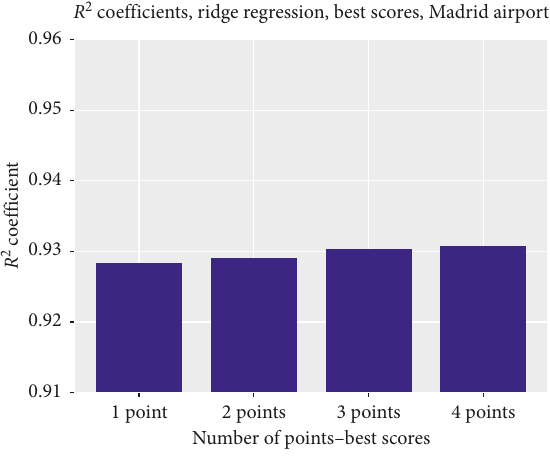
Figure 2: Quality of the ridge regression for the 4 closest points